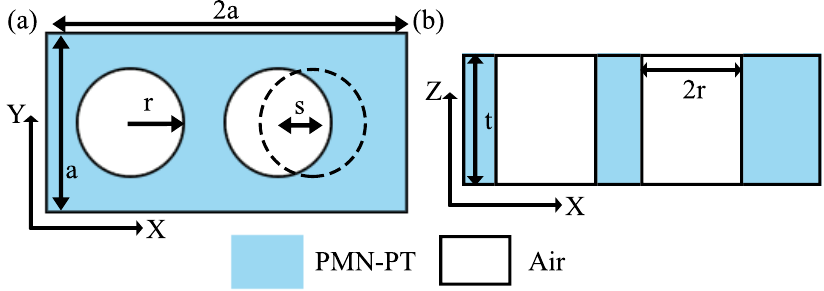
Figure 6. ( a ) 2D plane diagram of a PMN-PT rectangle unit cell in XY plane. ( b ) 2D plane diagram of a PMN-PT rectangle unit cell in XZ